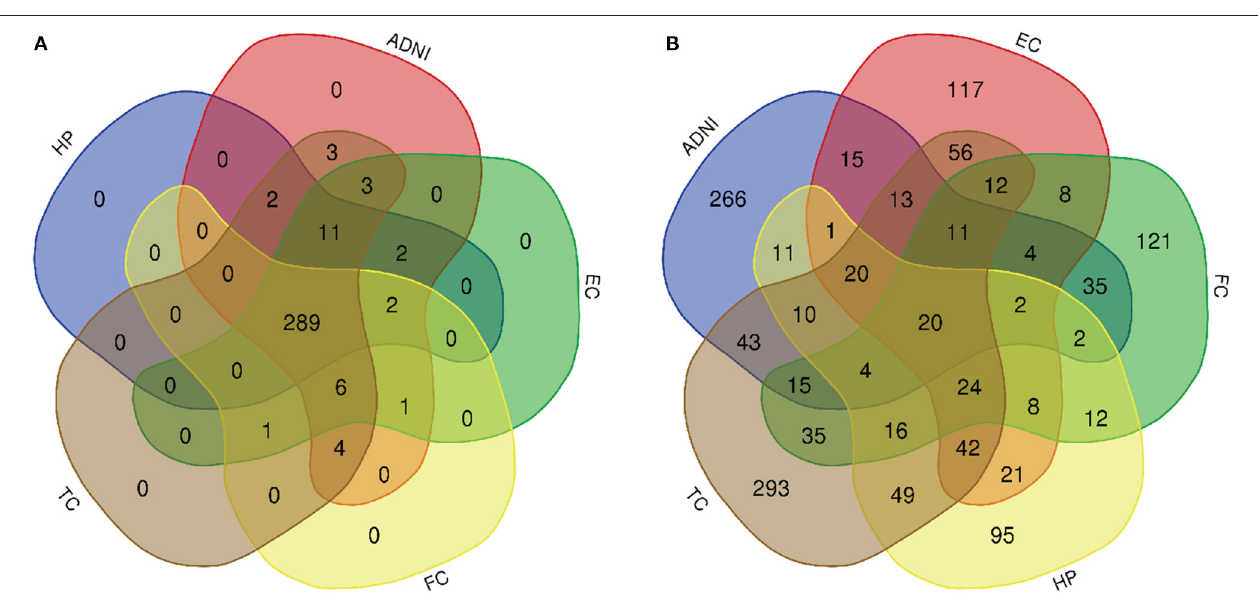
FIGURE 4 | Venn diagram is used to represent relationships between multiple datasets. (A) KEGG pathway and (B) GO term.